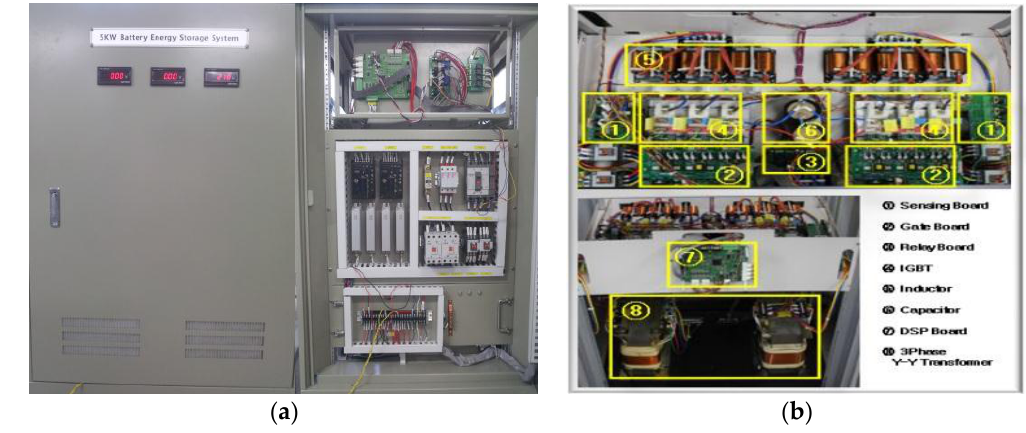
Figure 14. Hardware for experiments ( a ) 5 kW BESS; ( b ) 5 kW Load.